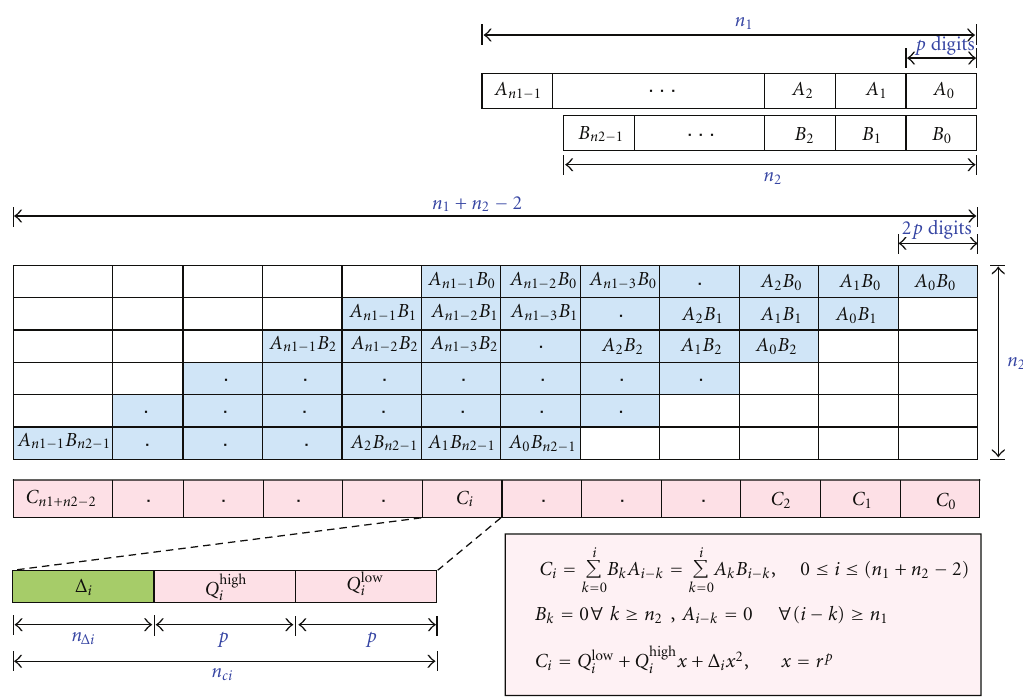
Figure 2: Multiplication matrix of high-precision